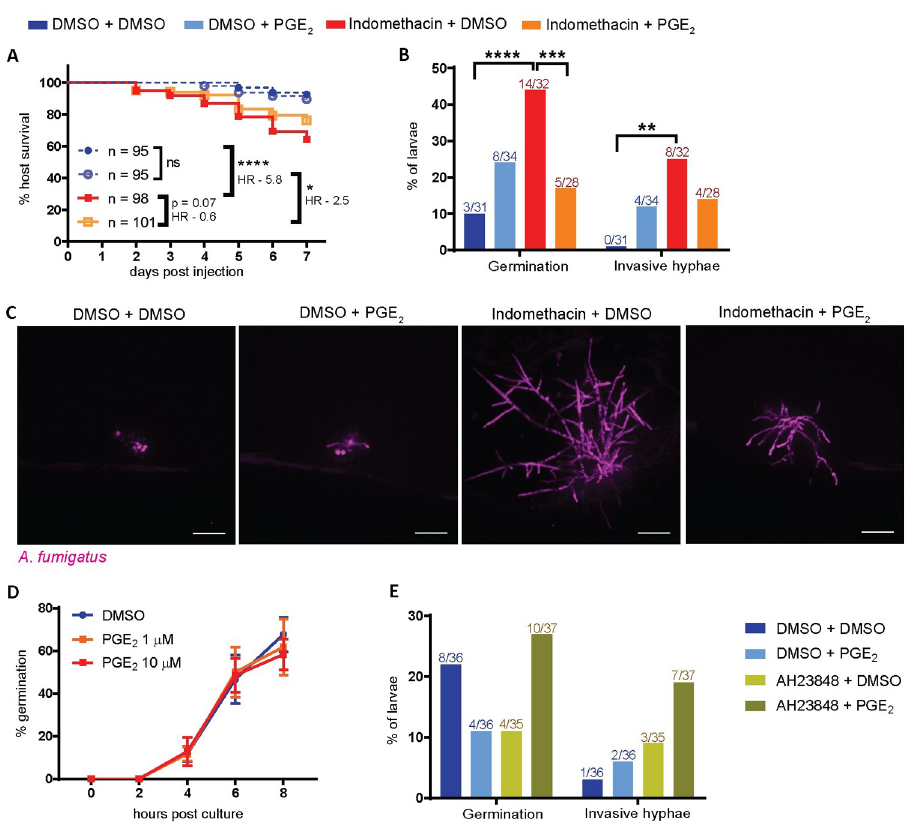
Fig 7. Exogenous PGE 2 can rescue the indomethacin-mediated increase in fungal germination and hyphal growth. Larvae were injected with mCherry-expressing TBK5.1 (Af293) spores and exposed to 10 μ M indomethacin or DMSO vehicle control at 2 dpf. At 1 dpi, larvae were injected with 10 μ M PGE 2 or DMSO vehicle control. (A) Survival of wild- type larvae was monitored. Cox proportional hazard regression analysis was used to calculate P values and hazard ratios (HR). Data are pooled from four independent replicates, at least 23 larvae per condition, per replicate and total larval N per condition is indicated. Average injection CFUs: 40. (B-C) Larvae were imaged at 3 dpi. (B) Percentage of larvae with germination and invasive hyphae. Data are pooled from three independent replicates, at least 8 larvae per condition, per replicate, P values calculated by Fisher’s Exact Test. (C) Representative images showing hyphal growth in each condition. Scale bars = 50 μ m. (D) TBK1.1 (Af293) spores were inoculated into RPMI media in the presence of 1 μ M PGE 2 , 10 μ M PGE 2 , or DMSO vehicle control. Every 2 hours, an aliquot of spores was removed and scored for germination. Points represent pooled means ± SEM from two independent replicates. (E) Larvae were injected with GFP-expressing TBK1.1 (Af293) spores and exposed to 5 μ M AH23848 or DMSO vehicle control at 2 dpf. At 1 dpi, larvae were injected with 10 μ M PGE 2 or DMSO vehicle control. Larvae were imaged at 3 dpi and the percentage of larvae with germination and invasive hyphae in each condition was calculated. Data are pooled from three independent replicates, at least 11 larvae per condition, per replicate, P values calculated by Fisher’s Exact Test. mediated COX inhibition promote an anti-inflammatory environment via the EP4 receptor, leading to lowered immune control of fungal growth [28]. Therefore, we tested if excess PGE 2 still leads to increased fungal germination and invasive hyphal growth when the EP4 receptor is also blocked. Infected larvae exposed to the EP4 antagonist AH23848 were injected with PGE at 1 dpi. However, in these experiments, PGE injection alone did not cause increased 2 2 fungal growth, possibly due to small differences in injection volume, further underlining how small differences in PGE levels can lead to different outcomes. Interestingly, however, expo- 2 sure to AH23848 alone or in combination with PGE increased invasive hyphal growth in 2 infected larvae, although these differences were not statistically significant (Fig 7E). These data together with the slightly increased mortality of infected larvae in the presence of AH23848